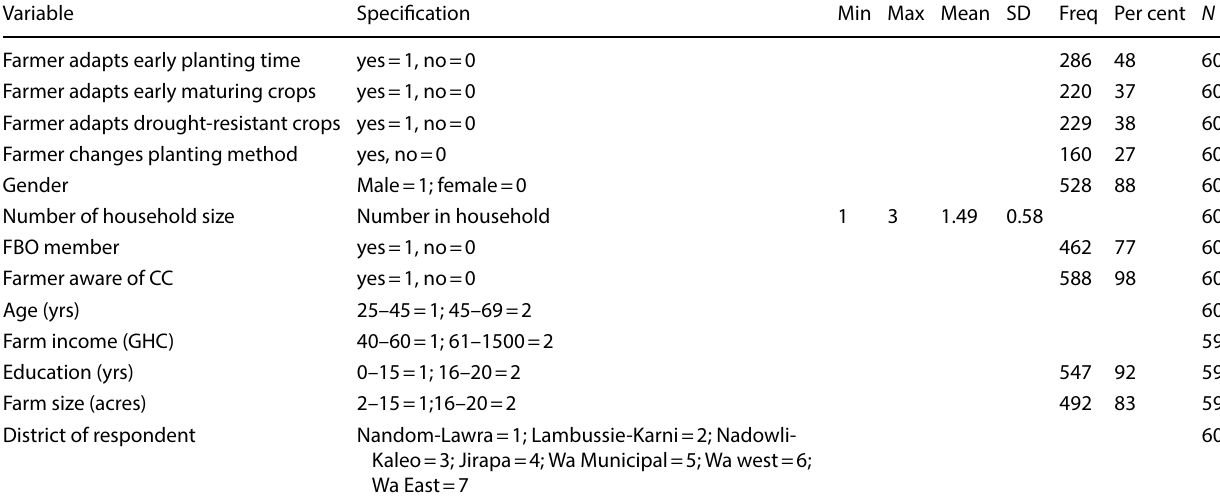
Table 4 Respondents socio-economic characteristics and response to climate change adaptation strategies for the binary logistic model